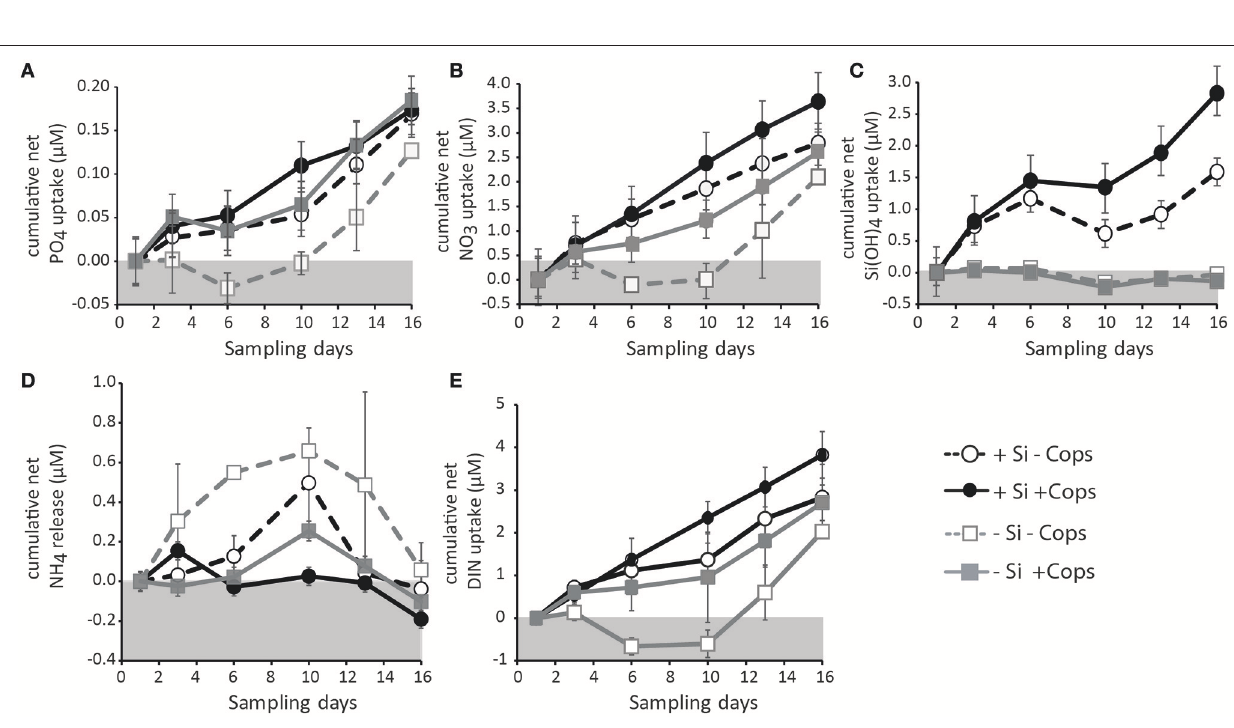
Frontiers in Marine Science |